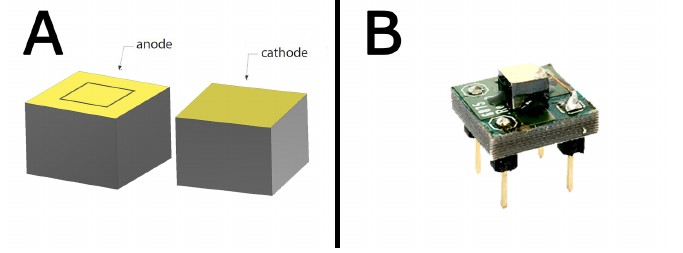
Figure 4. ( A ) 3D model of the single pixel detector; ( B ) actual CZT detector bonded to the intermediate electronic board.